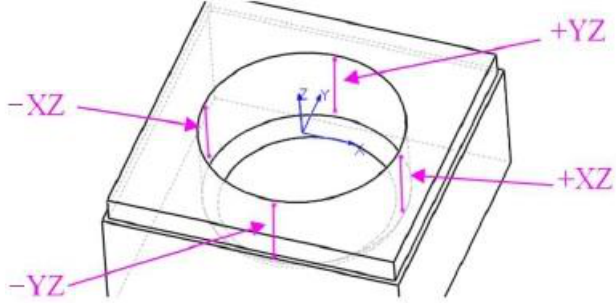
Figure 9. Representation of the measurement paths in the form of a line segment.